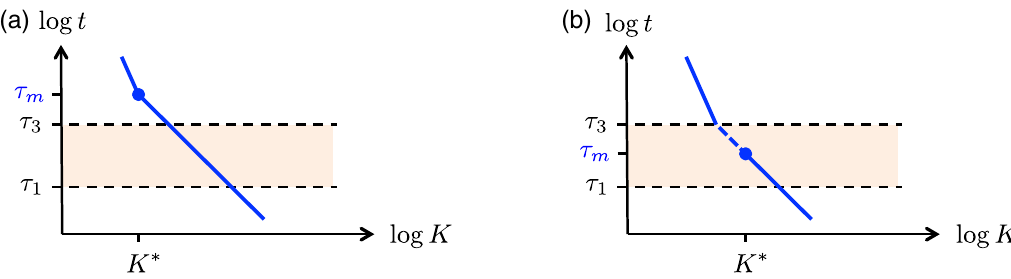
FIG. 7. Dynamic scaling diagrams for (a) a large solute particle and for (b) a small particle. In (a) the inertial time scale τ the longest water relaxation time τ 3 and the particle relaxation time in the potential (shown as a solid line) changes from the harmonic ffiffiffiffiffiffiffiffiffiffi p m=K oscillator prediction τ 0 ≃ 2 π (for K > K (cid:4) ) to the overdamped prediction τ γ ≃ 2 πγ =K (for K < K (cid:4) ) above τ 3 . In (b) τ than τ 3 and the potential relaxation time becomes overdamped within the relaxation time range. In this case we expect the external potential of strength K to modify the particle